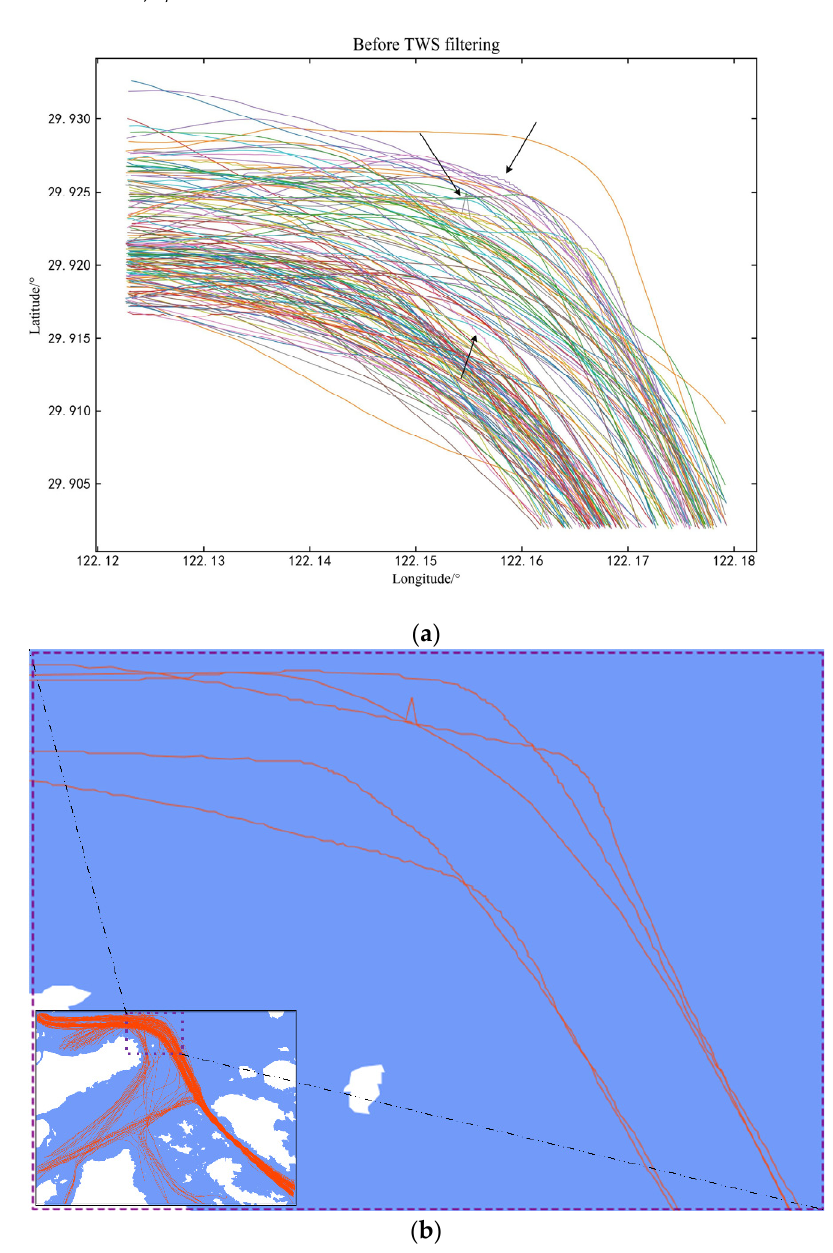
Figure 2. Trajectory before time window panning and smoothing filtering: ( a ) Vessel trajectory in the geographical area before filtering, the arrows point out the jagged or rippled localization in the anomalous trajectory ( b ) Mapping of parts of anomalous trajectories in a geographical area.